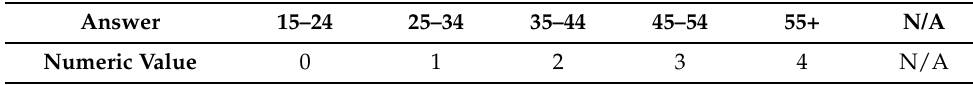
Table 2. Numeric values for the Age Category (D1) of the participants.